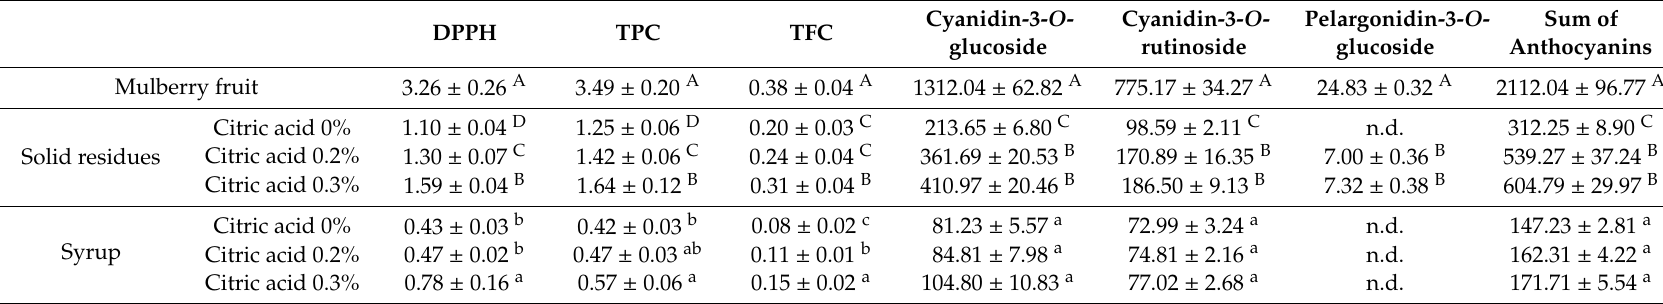
Table 6. Antioxidant activity (DPPH), total phenolic contents, total flavonoid contents, and anthocyanin contents of mulberry fruits, solid residues, and syrup ( µ g / g